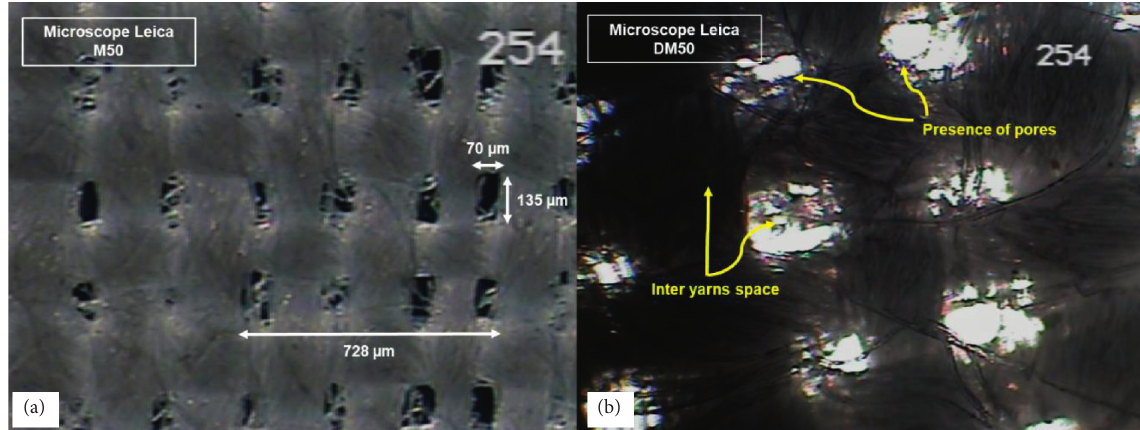
Figure 5: Surface morphology of the uncoated cotton-PES blended woven fabric. (a) 51X on-screen magnification and (b) 128X on-screen